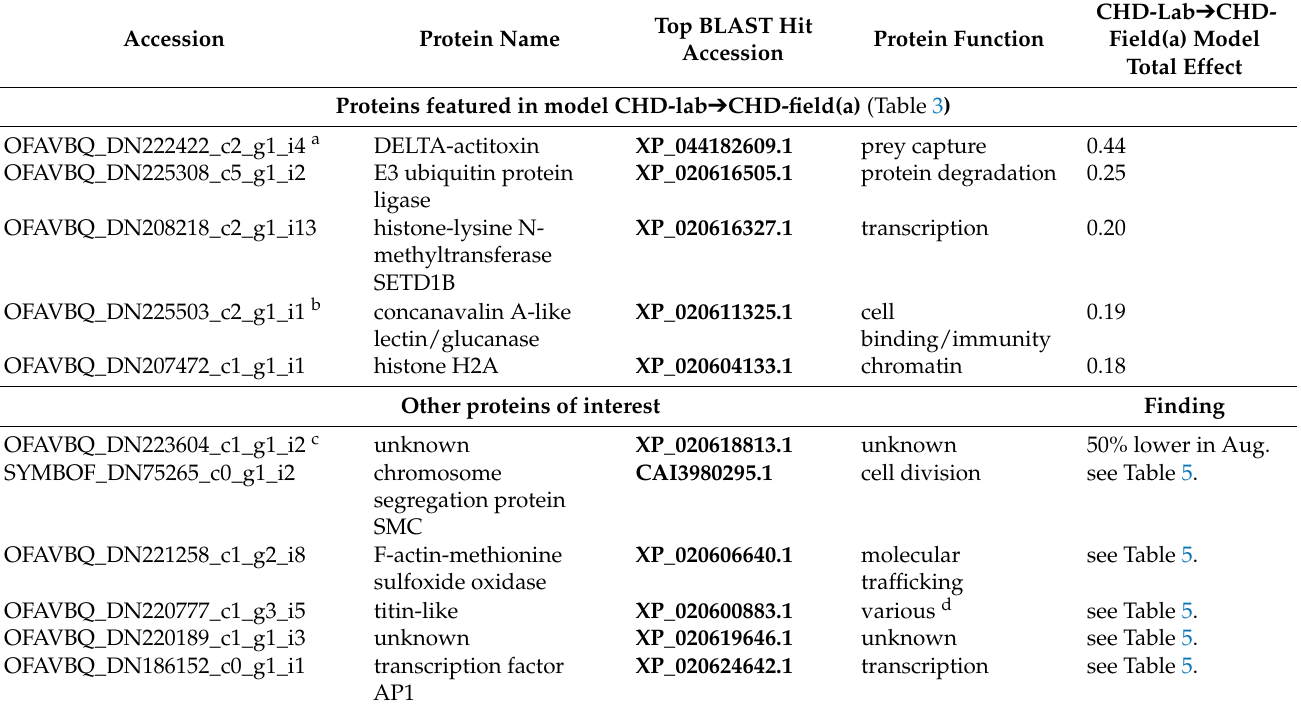
Table 4. Subset of host coral (OFAV) and Symbiodiniaceae (SYMBOF) proteins featured in proteomic predictive modeling analyses. All e -values were <10 − 80 , and the top hit was always a scleractinian coral for the host (typically O. faveolata or Acropora millepora ). The “model total effect” was derived from a dependent resampled inputs analysis. AB = actively bleaching. CHD = colony health designation. HC = healthy controls. NA = not